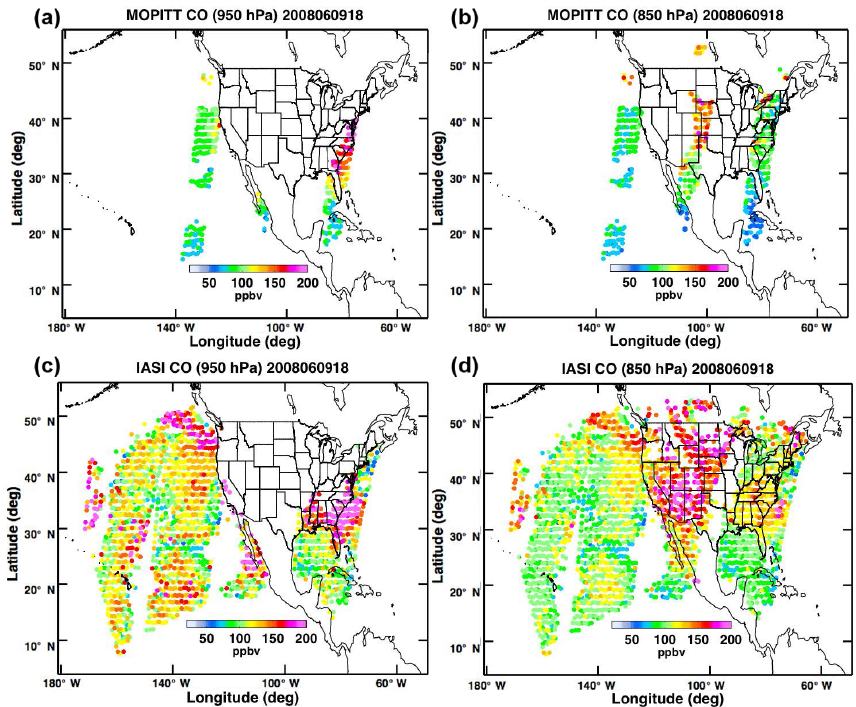
Figure 6. The assimilated MOPITT CO retrievals in panels (a) and (b) and the corresponding IASI CO retrievals (not assimilated) in panels (c) and (d) . Panels (a) and (c) are for ∼ 950hPa, and panels (b) and (d) are for ∼ 850hPa. All figures are for the 9 June 2008, 18:00UTC, cycle. The retrievals are in ppb.